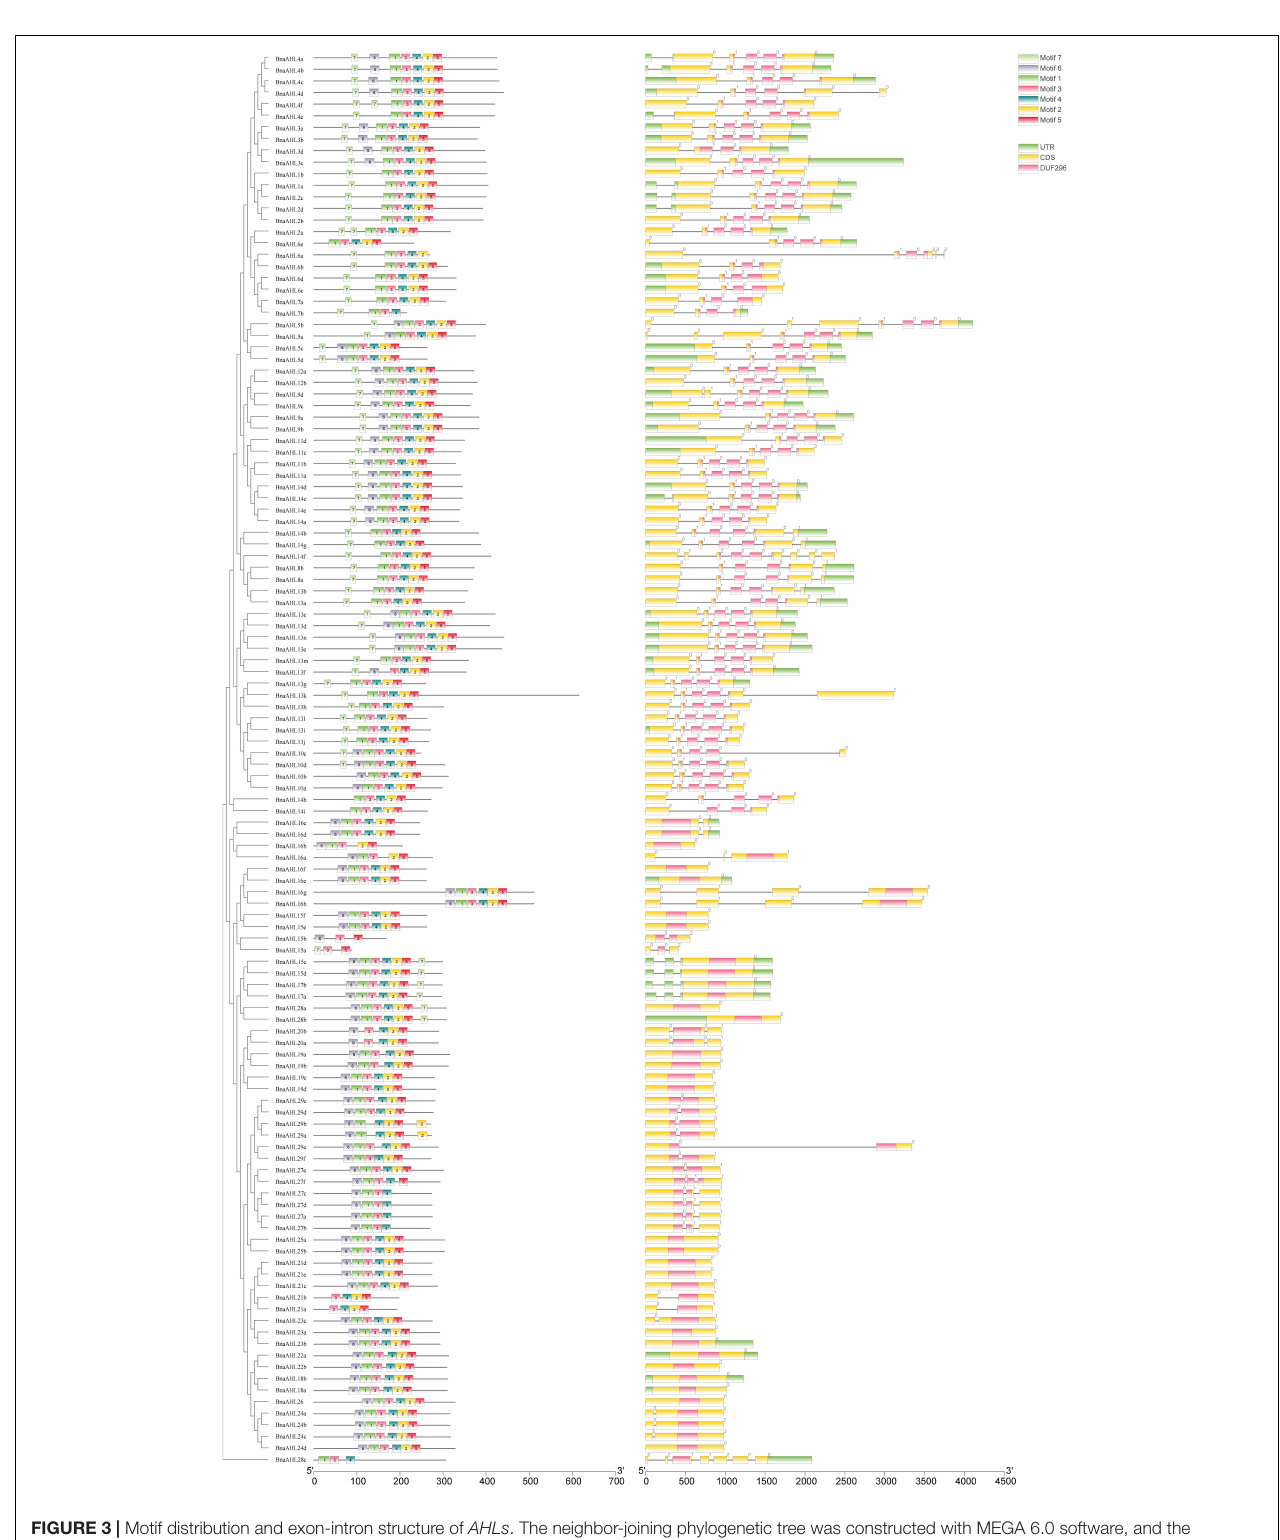
FIGURE 3 | Motif distribution and exon-intron structure of AHLs . The neighbor-joining phylogenetic tree was constructed with MEGA 6.0 software, and the conserved motifs and gene structure were predicted with MEME and Tbtools, respectively. The scale at the bottom indicates the length of protein and DNA sequences, respectively. In the left picture, different colored boxes indicate different conserved motifs, and the black line indicates non-conserved amino acids. The black line on the right represents introns, the green box represents untranslated 5 (cid:48) and 3 (cid:48) regions; the yellow box represents exons, and the purple box represents the conserved domain of the AHLs